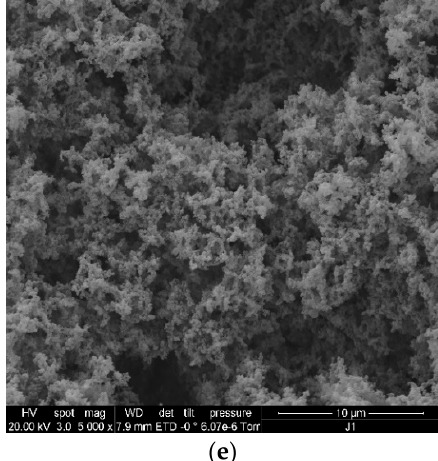
Figure 2. SEM images of plain ADG 0% ( a ), ADG with 15% black tea infusion ( b ), ADG with 30% black tea infusion ( c ), ADG with 45% black tea infusion ( d ), ADG with 60% black tea infusion ( e ) (day 1).